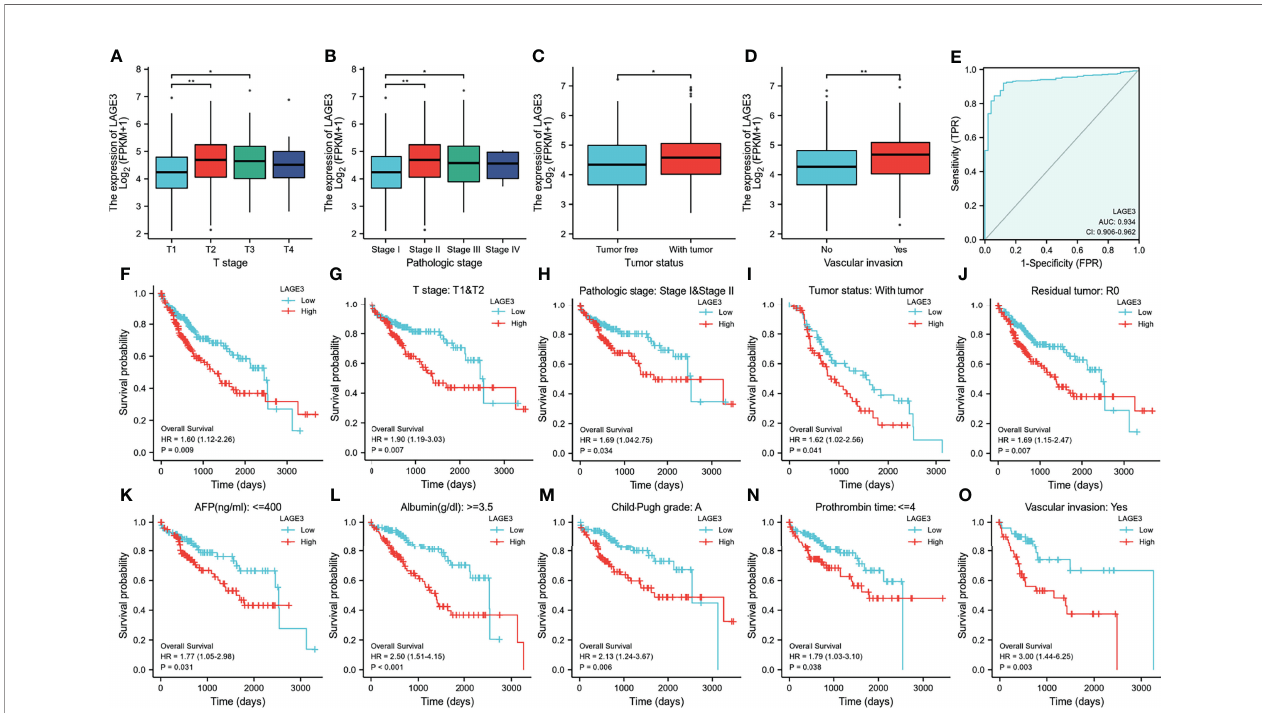
FIGURE 3 | Correlation between LAGE3 expression and clinical features, diagnostic value and prognosis of LAGE3 expression in HCC patients. (A-D) In the TCGA database, LAGE3 expression in the different status of (A) T stage; (B) pathologic stage; (C) tumor status, and (D) vascular invasion. The data were analyzed by Wilcoxon signed-rank test. * P < 0.05, ** P < 0.01. (E) ROC curve for LAGE3 in normal liver tissue and HCC. Kaplan-Meier curves showing the overall survival linked to LAGE3 expression in HCC. (F) Based on TCGA datasets, Kaplan-Meier curve for LAGE3 in all HCC patients; (G – O) In the TCGA database, subgroup analysis for